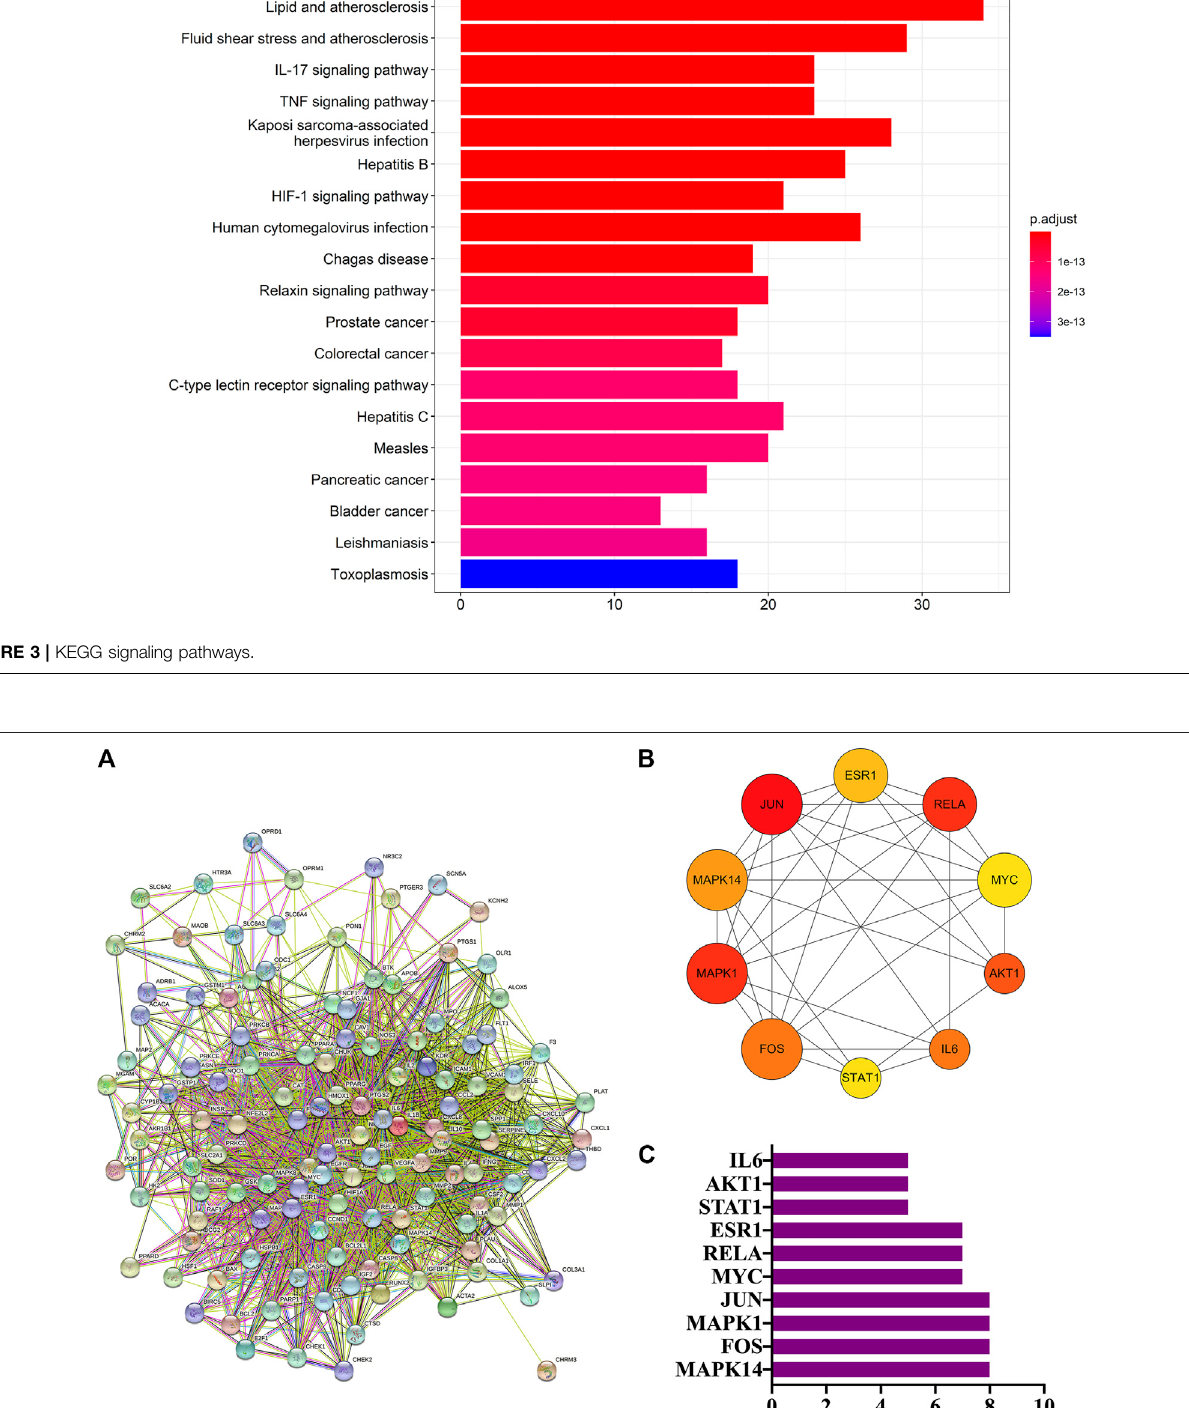
Frontiers in Pharmacology |